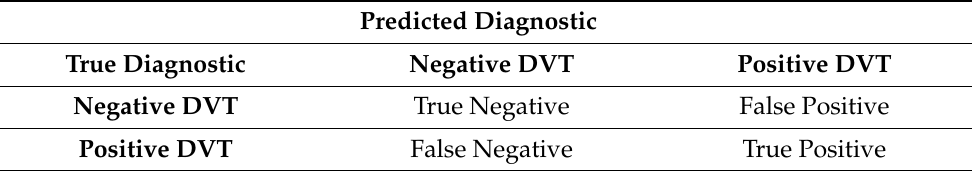
Table 6. Confusion matrix of two-class classification, taken from